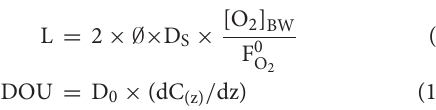
which the generation of excess organic matter fuels near-bottom water O 2 consumption (Diaz,